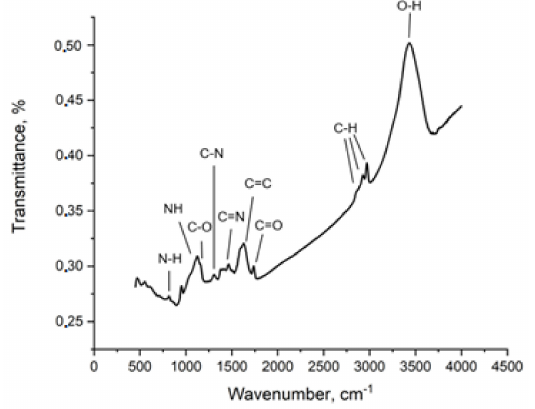
Figure 6. IR-spectrum of the r-GO/o-CNTs/PANI nanocomposite